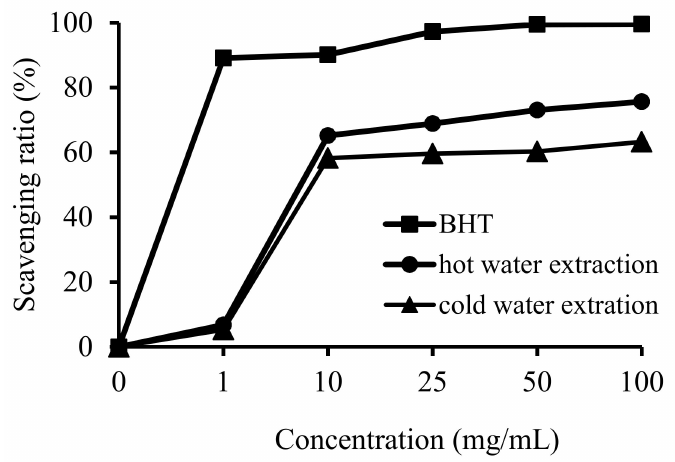
Figure 2. DPPH free radical scavenging ability of the butterfly pea flower extracts.